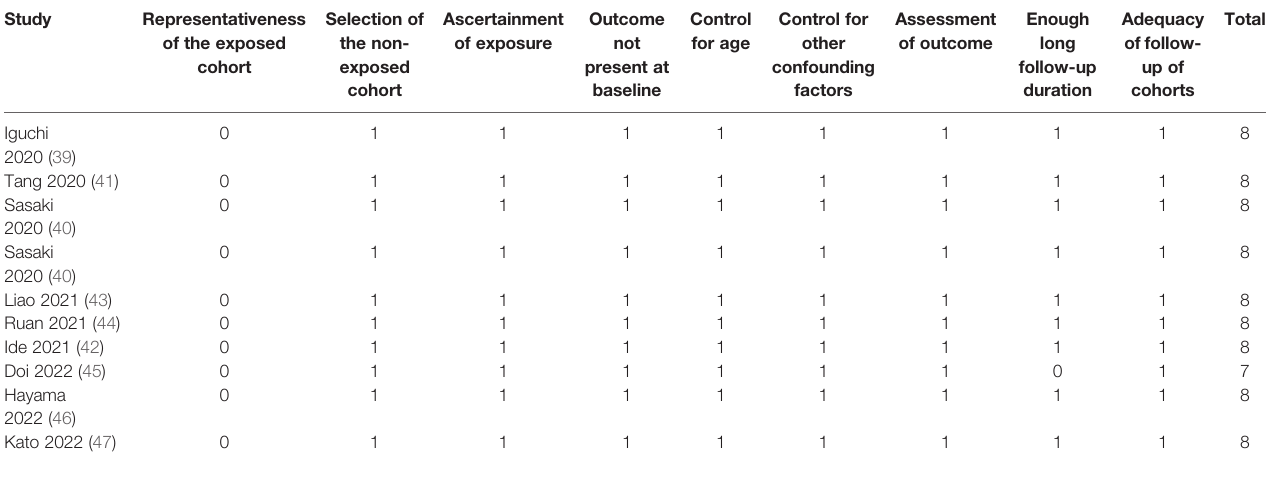
TABLE 2 | Details of study quality evaluation via the Newcastle-Ottawa Scale.